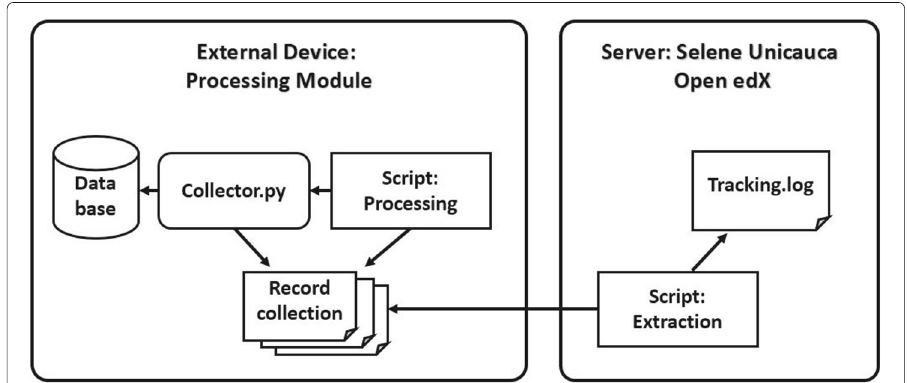
Fig. 1 General architecture mechanism for data